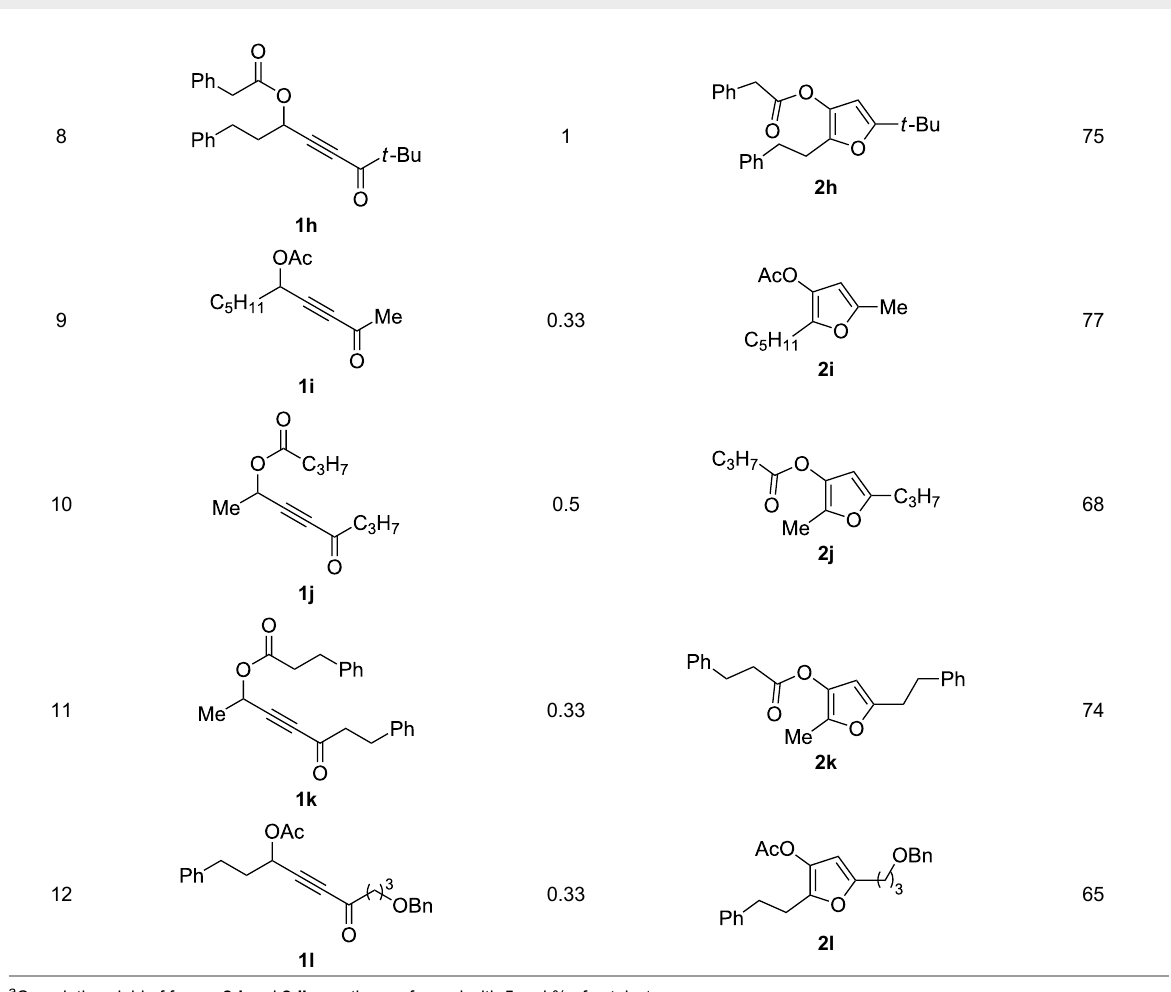
Table 2: Scope of the gold(I)-catalyzed formation of furans from γ -acyloxyalkynyl ketones.